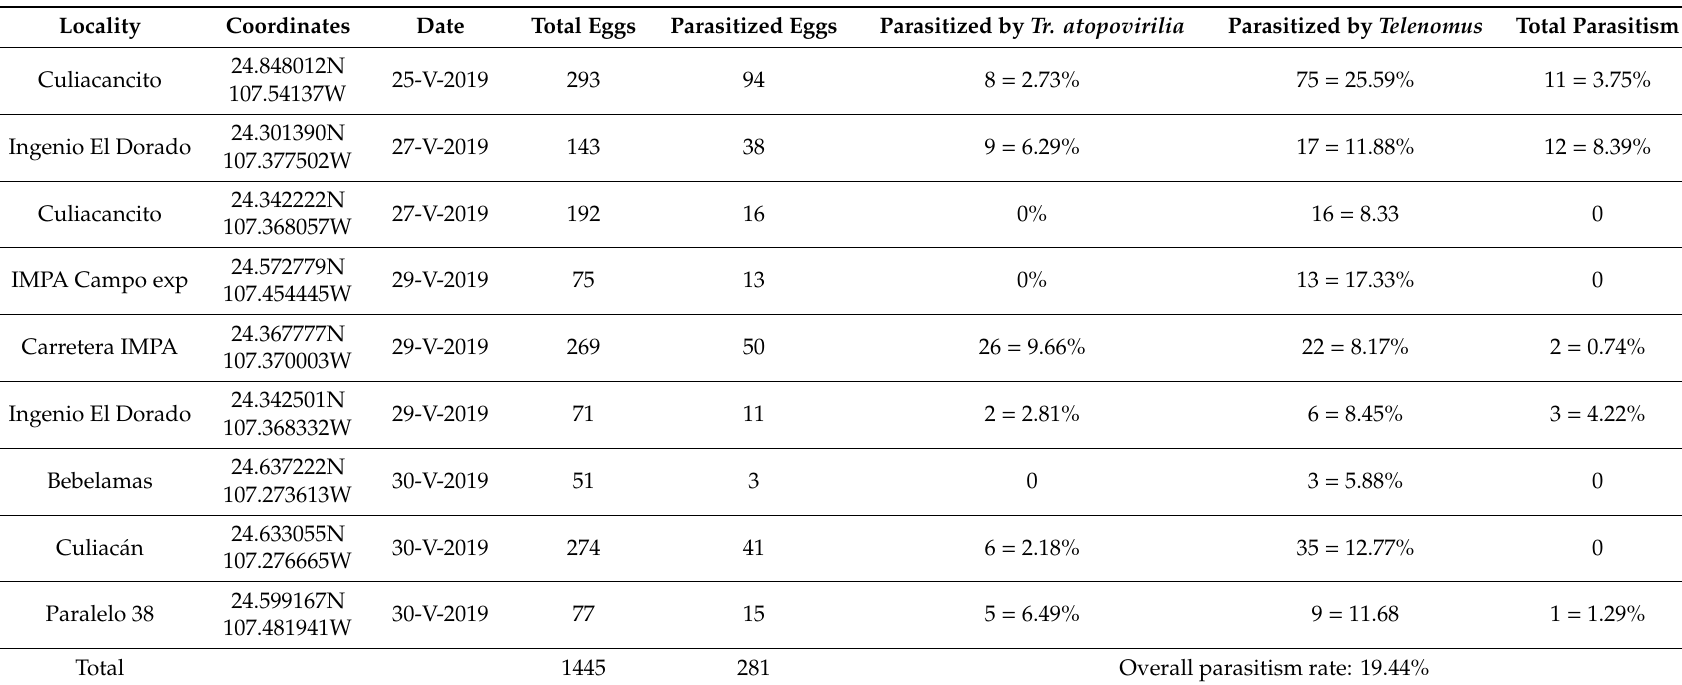
Table 2. Collection dates, localities, and number of chrysopid eggs collected in field surveys in Sinaloa during